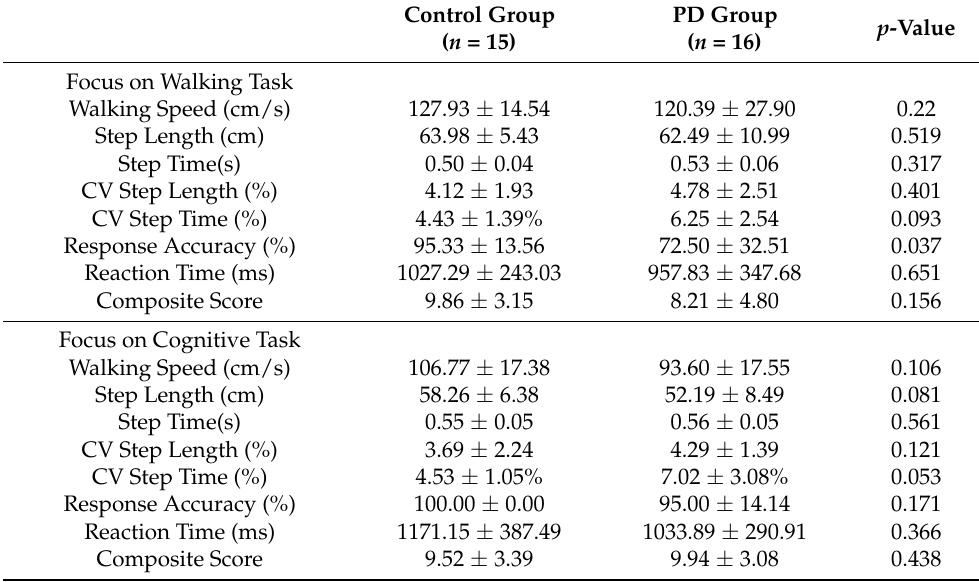
Table 3. The dual tasks in the designated task